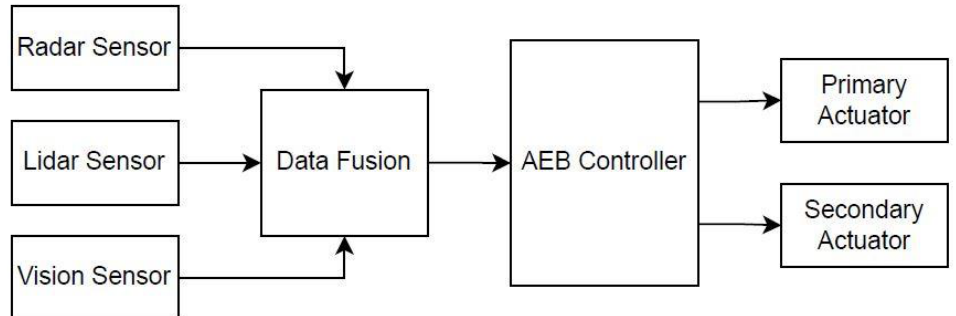
Figure 4. Block diagram of AEB with sensor fusion.